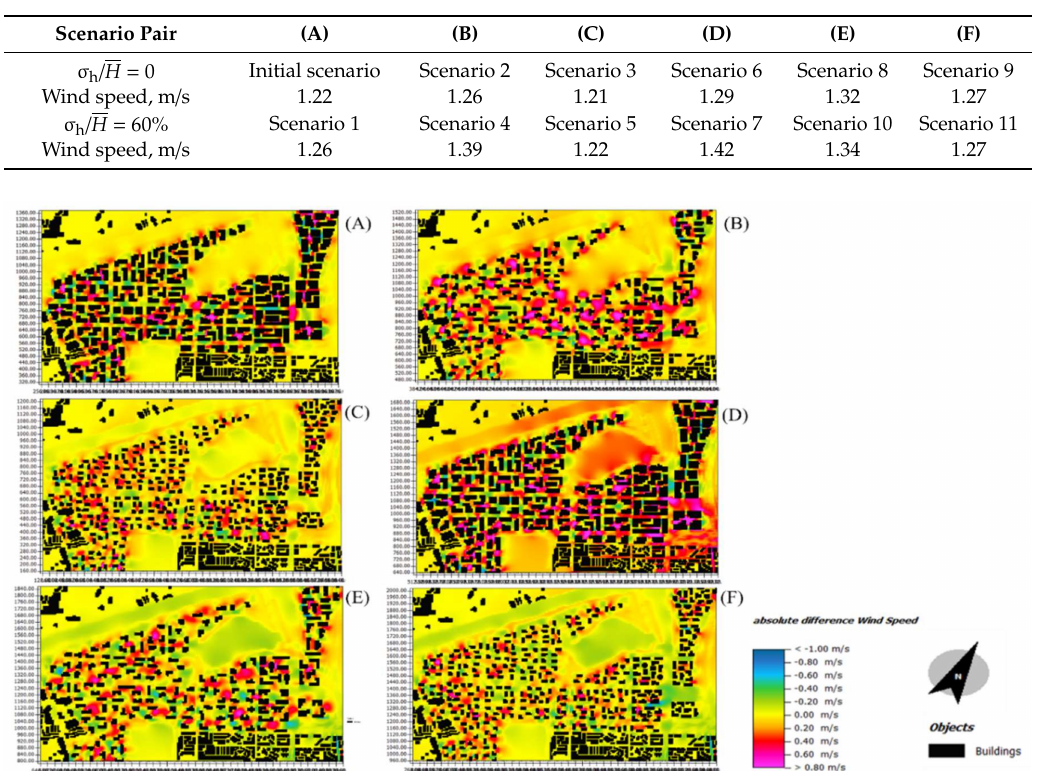
Table 7. Comparison of 24-h-averaged mean wind speed between pairs of scenarios with di ff erent coe ffi cients of variation for building height.